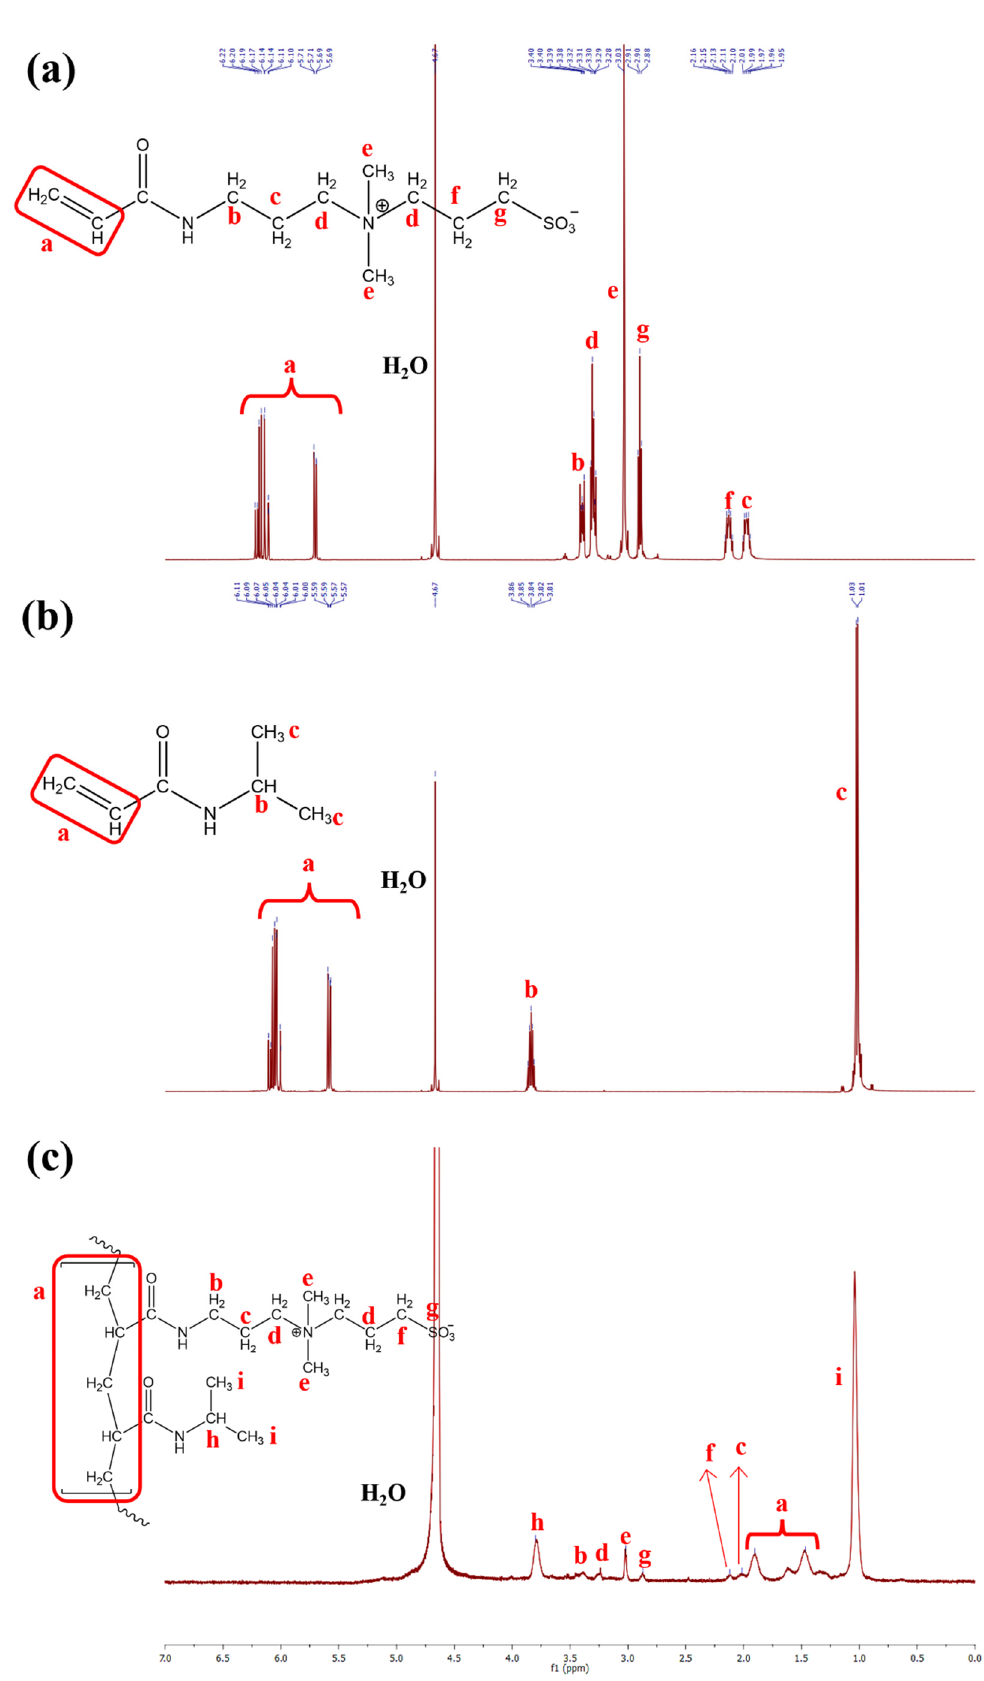
Figure 2. 1 H NMR spectra of DMAAPS ( a ) and NIPAAM ( b ) monomer and the resulting poly(DMAAPS- co -NIPAAM) ( c ). The NIPAAM:DMAAPS molar ratio is 95:5.